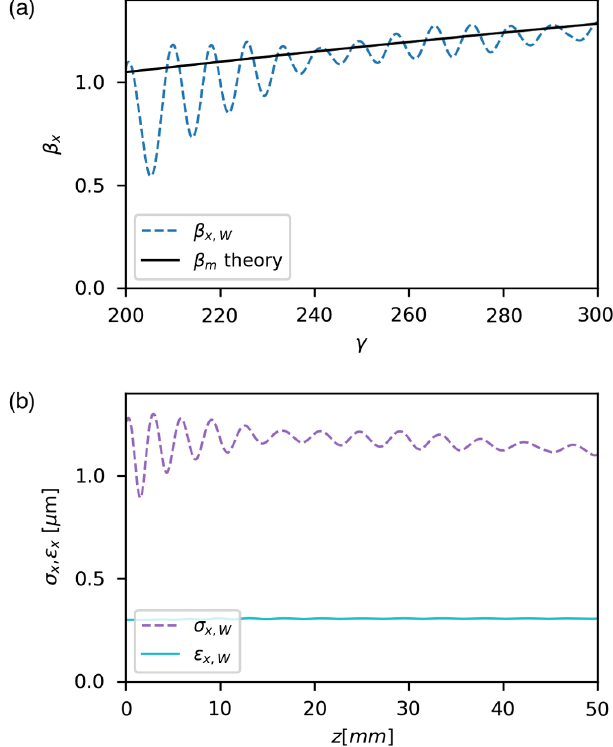
FIG. 3. Transverse evolution of the witness. In (a) is displayed the evolution of the β function versus the mean energy γ compared to Eq. (1). In (b) is displayed the envelope and normalized emittance evolution.